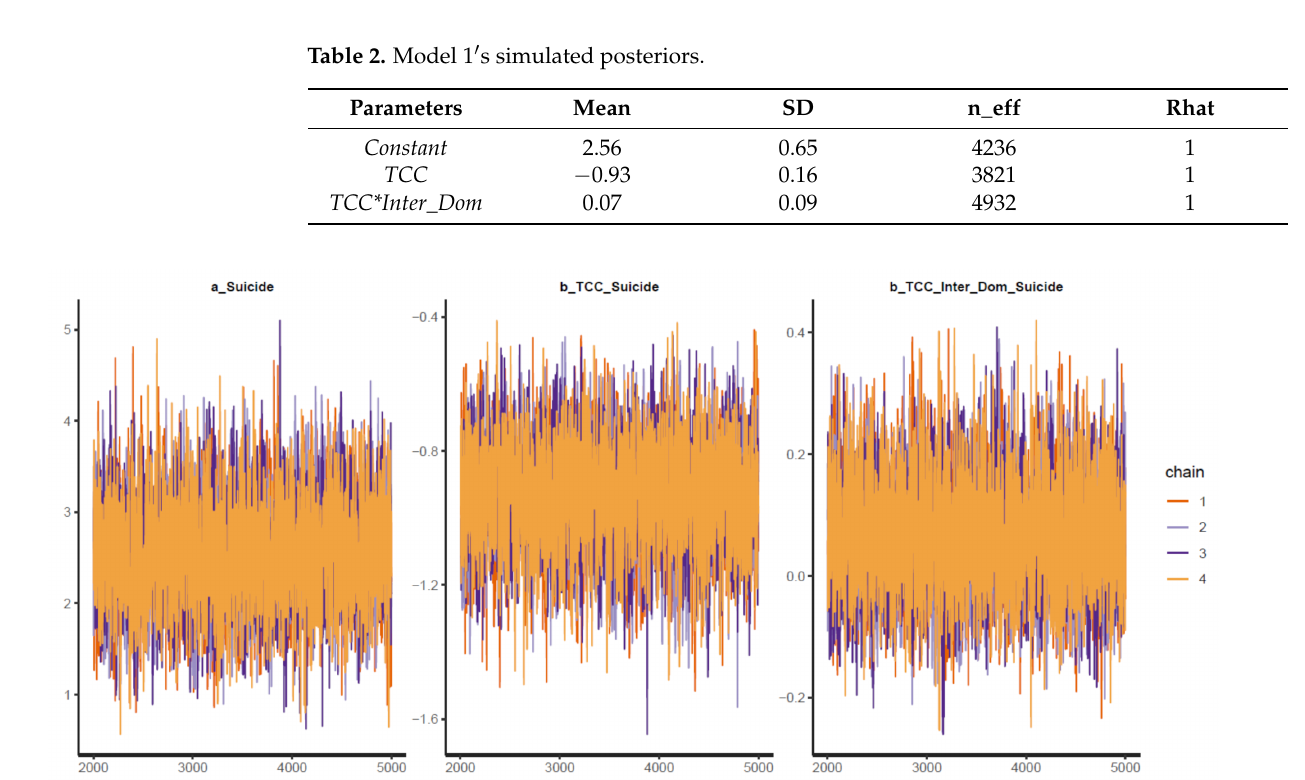
Figure 4. Trace plots for Model 1 (cid:48) s posterior coefficients.